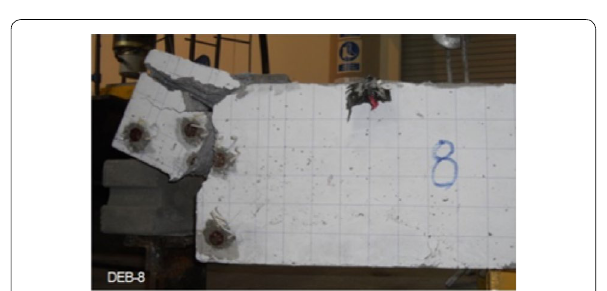
Fig. 11 The beam condition after testing (For